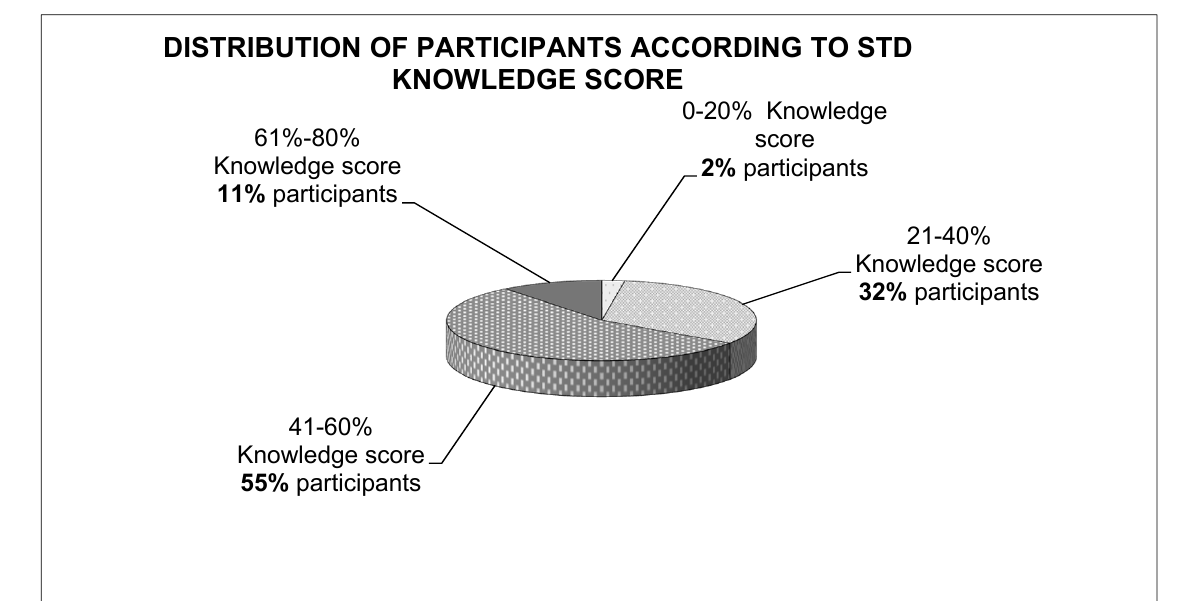
Figure 1. Distribution of participants according to STD knowledge score. Table 5. Unifactorial analysis of STD knowledge score in relation to demographic characteristics of the young Greek